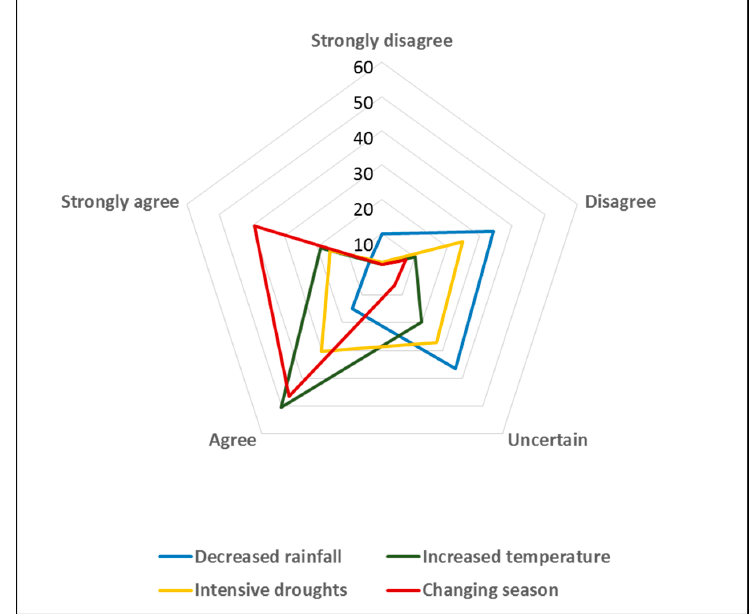
Figure 2. Farmers’ perceptions of climate variability quantified by % response for five levels of agreement: Strongly disagree, Disagree, Uncertain, Agree, Strongly agree (Likert type).